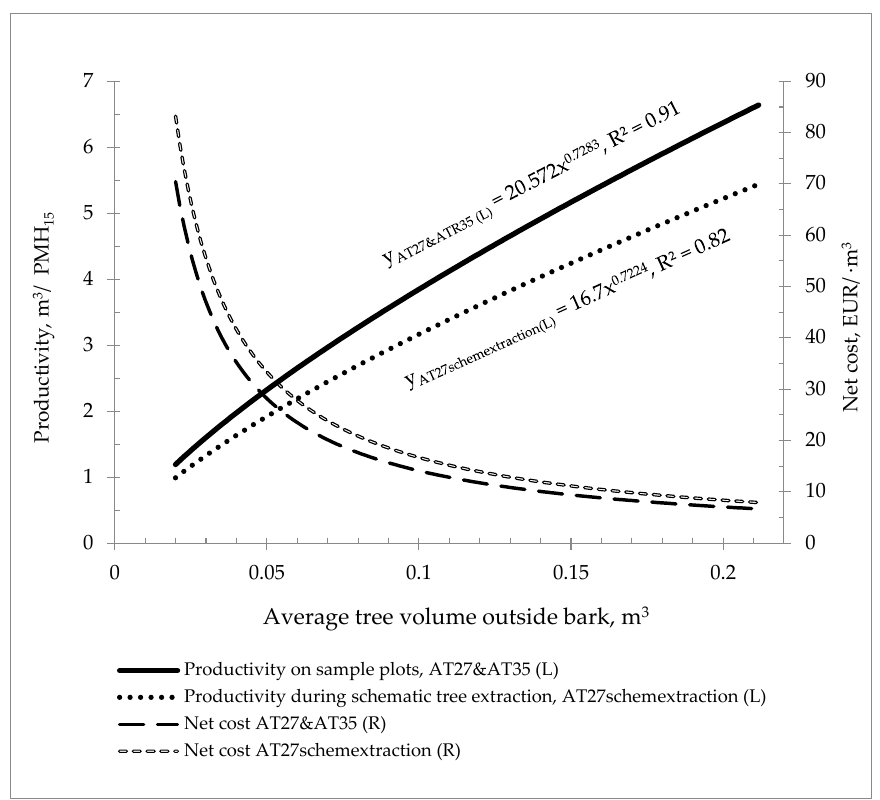
Figure 2. Productivity and net cost of using the mini-harvester with Arbro 400 S as a function of average tree volume. Table 8. Linear regression analysis of the productivity (Equation (1)) of the mini-harvester with an